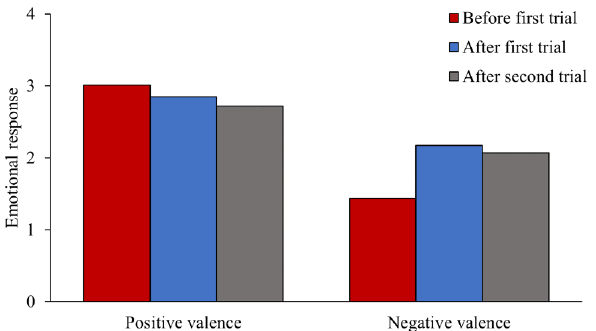
Figure 4. The effect of valence × time interaction on participants’ emotional